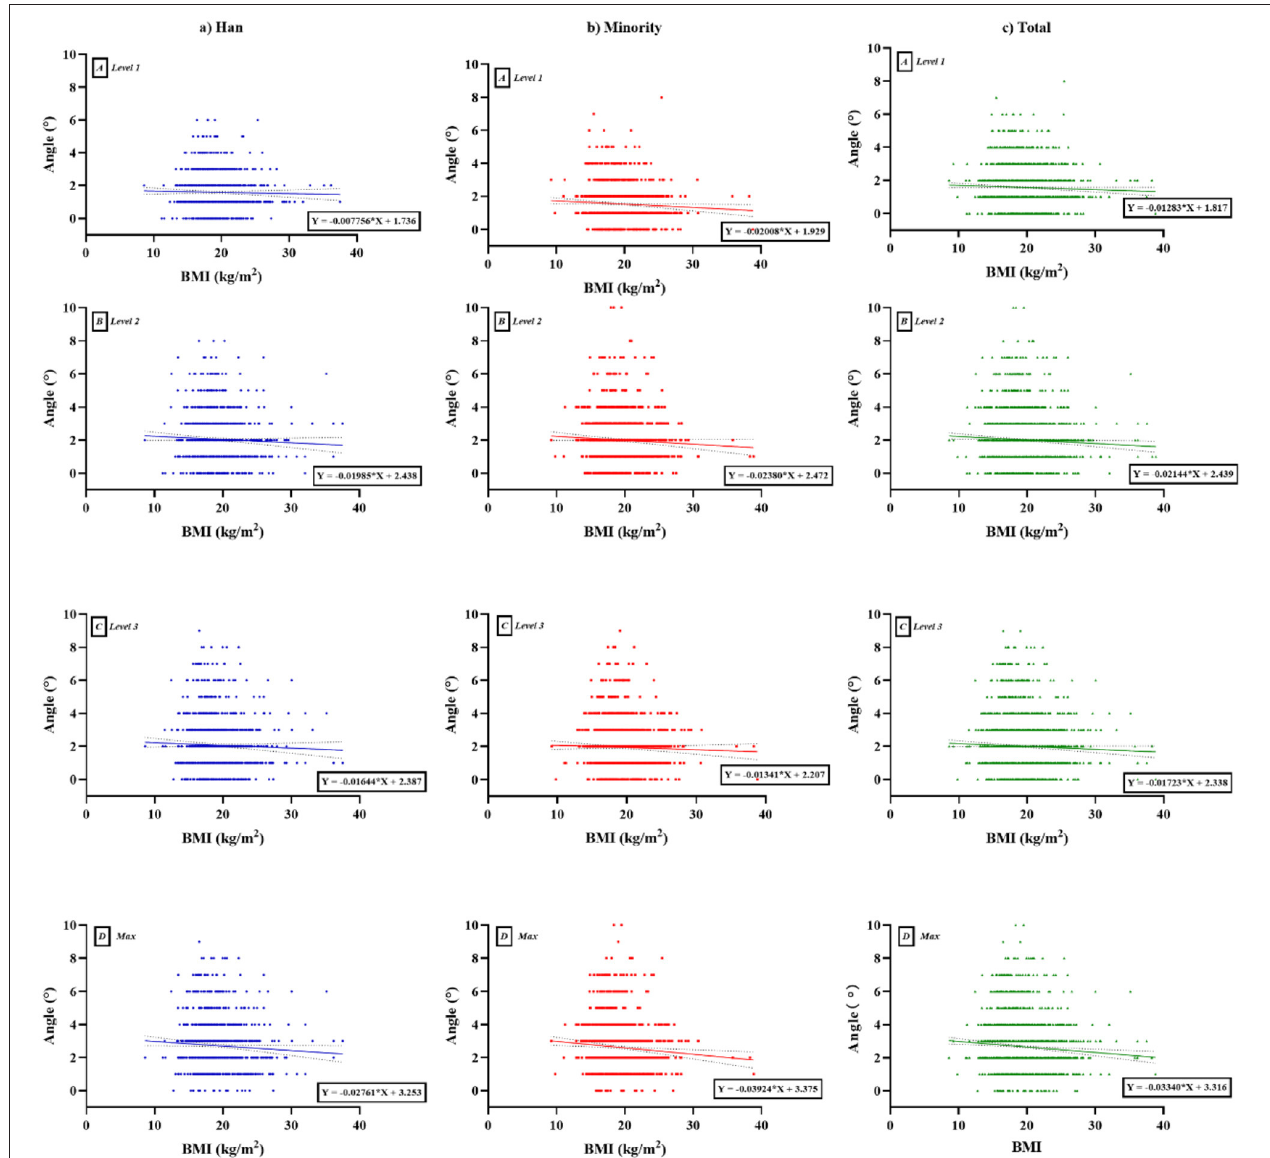
FIGURE 3 | Scatter plot with trend line according to BMI and ATR between Han and ethnic minority groups. (A) Level 1, proximal thoracic (T1–T4); (B) level 2, main thoracic (T5–T12); (C) level 3, lumbar (T12–L4); (D) Max, maximum value among the three levels. (a) Han, (b) minority, (c) total. BMI, body mass index; ATR, angle of trunk